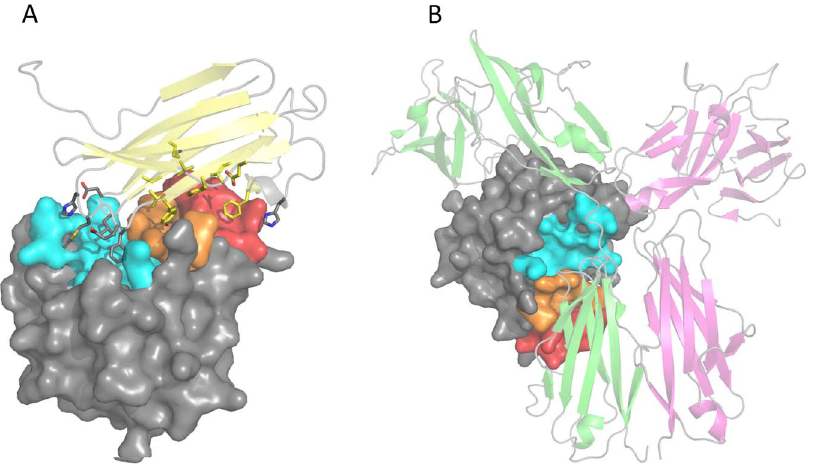
Figure 1. Human IL-18 Viral and Ternary Receptor Complex Crystal Structures. ( A ) Crystal structure of hIL-18:ectvIL-18BP viral complex, PDB entry 3F62. Depicted in ribbon diagram and colored in light yellow is ectvIL-18BP, hIL-18 is drawn in surface representation. Residues of ectvIL-18BP at the interface are shown as sticks, interacting with previously identified binding sites on hIL-18 colored as site A (red), site B (orange), and site C (cyan). The remaining surface of hIL-18 is colored in grey. ( B ) Crystal structure of hIL-18 ternary receptor complex, PDB entry 3WO4. Drawn as cartoon representation and colored green and magenta are hIL- 18 Receptor α and β , respectively. Human IL-18 has been drawn as seen in panel